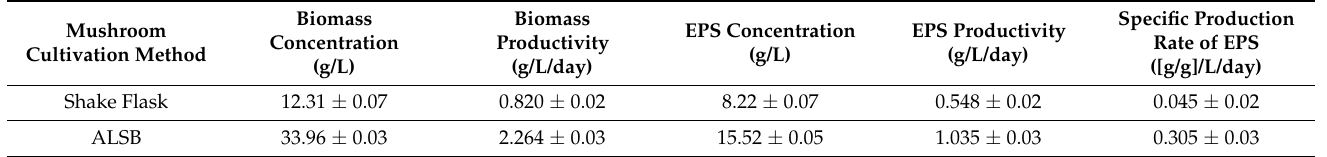
Table 2. Kinetic parameters of G. lucidum in shake flask compared to ALSB.